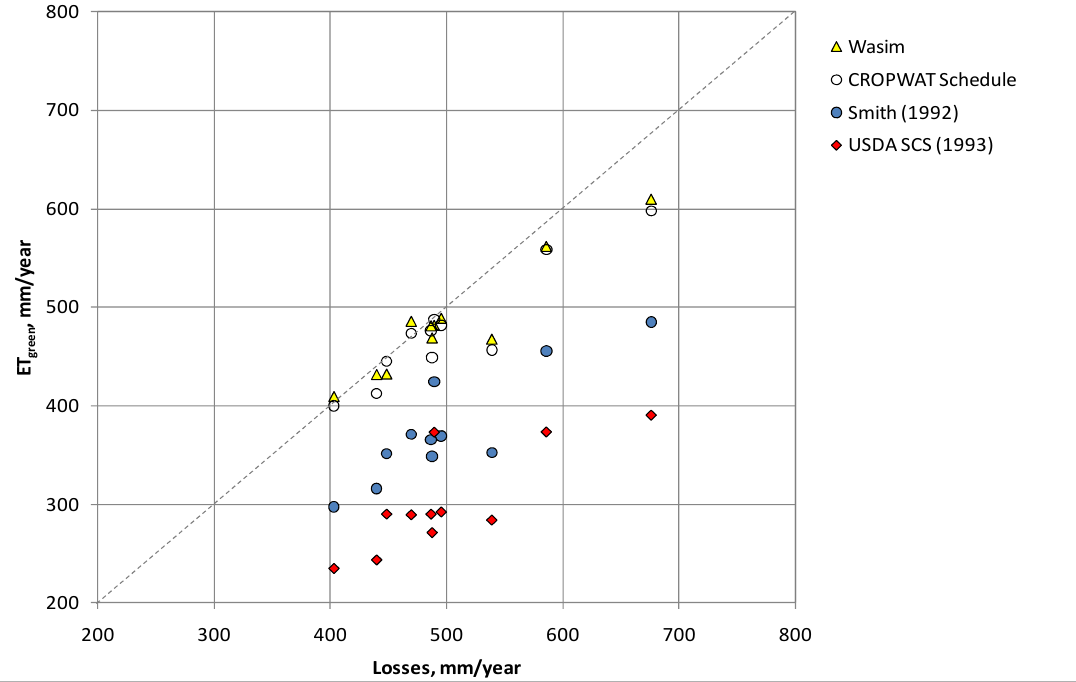
estimated green